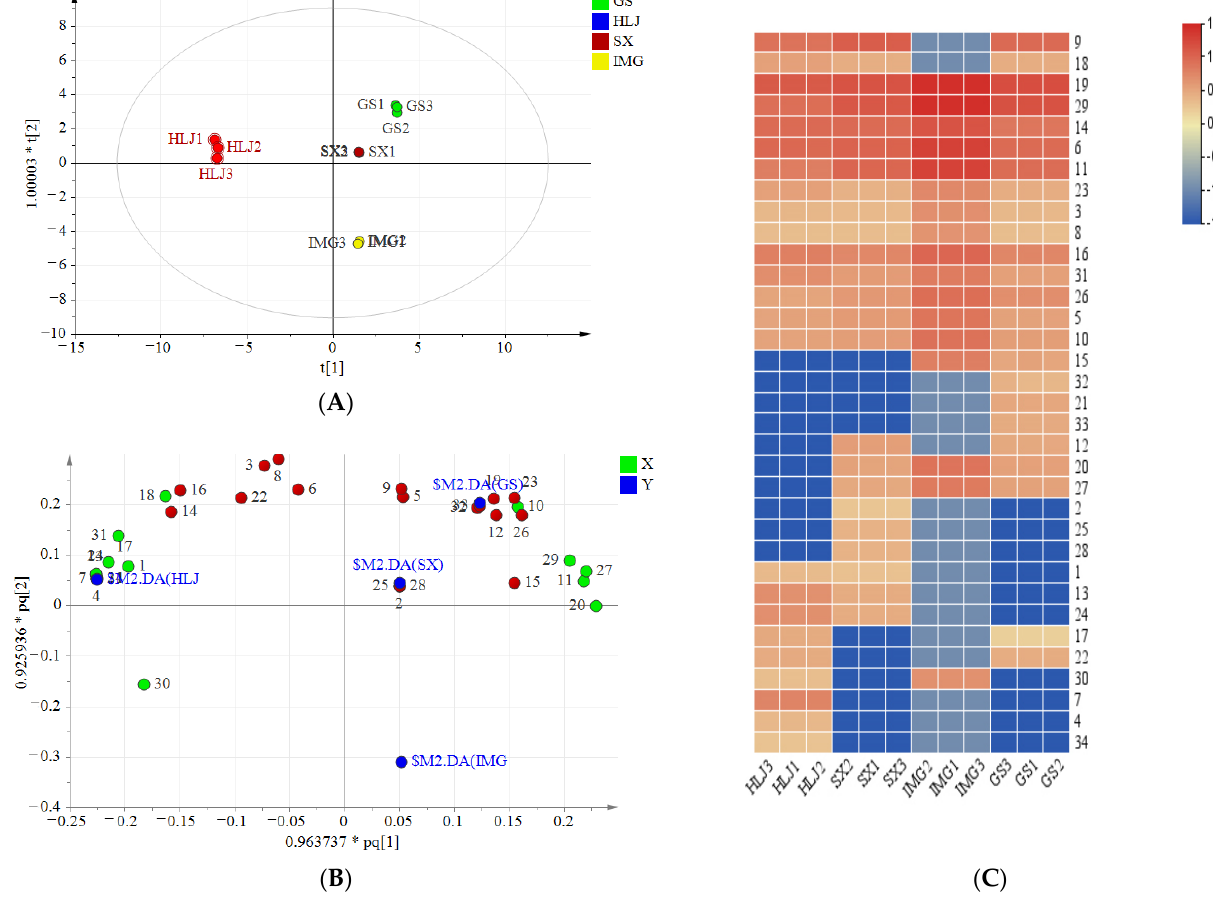
Figure 3. Multivariate statistical analysis of flavonoids in A. membranaceus from Gansu (GS), Heilongjiang (HLJ), Shanxi (SX), and Inner Mongolia (IMG): ( A ) OPLS-DA score plot; ( B ) OPLS-DA loading plot. The important compounds are in red colour. ( C ) Heatmap of phenolic components in astragalus from different origins. The levels of identified compounds were compared by their peak integration.